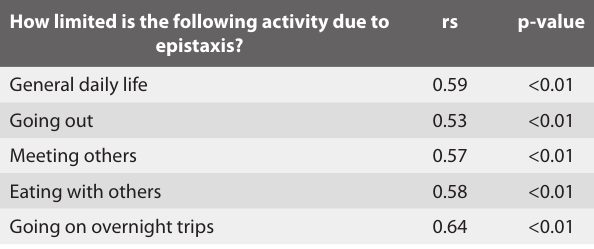
Table 3. Relationship between the epistaxis severity score and the per- formed activities of daily living.